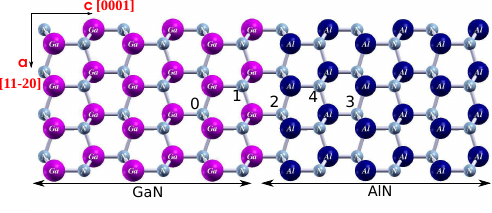
Figure 4. Model of the AlN/GaN interface with the studied lattice sites i = 0,. . . , 4 of nitrogen vacancy V 0 N